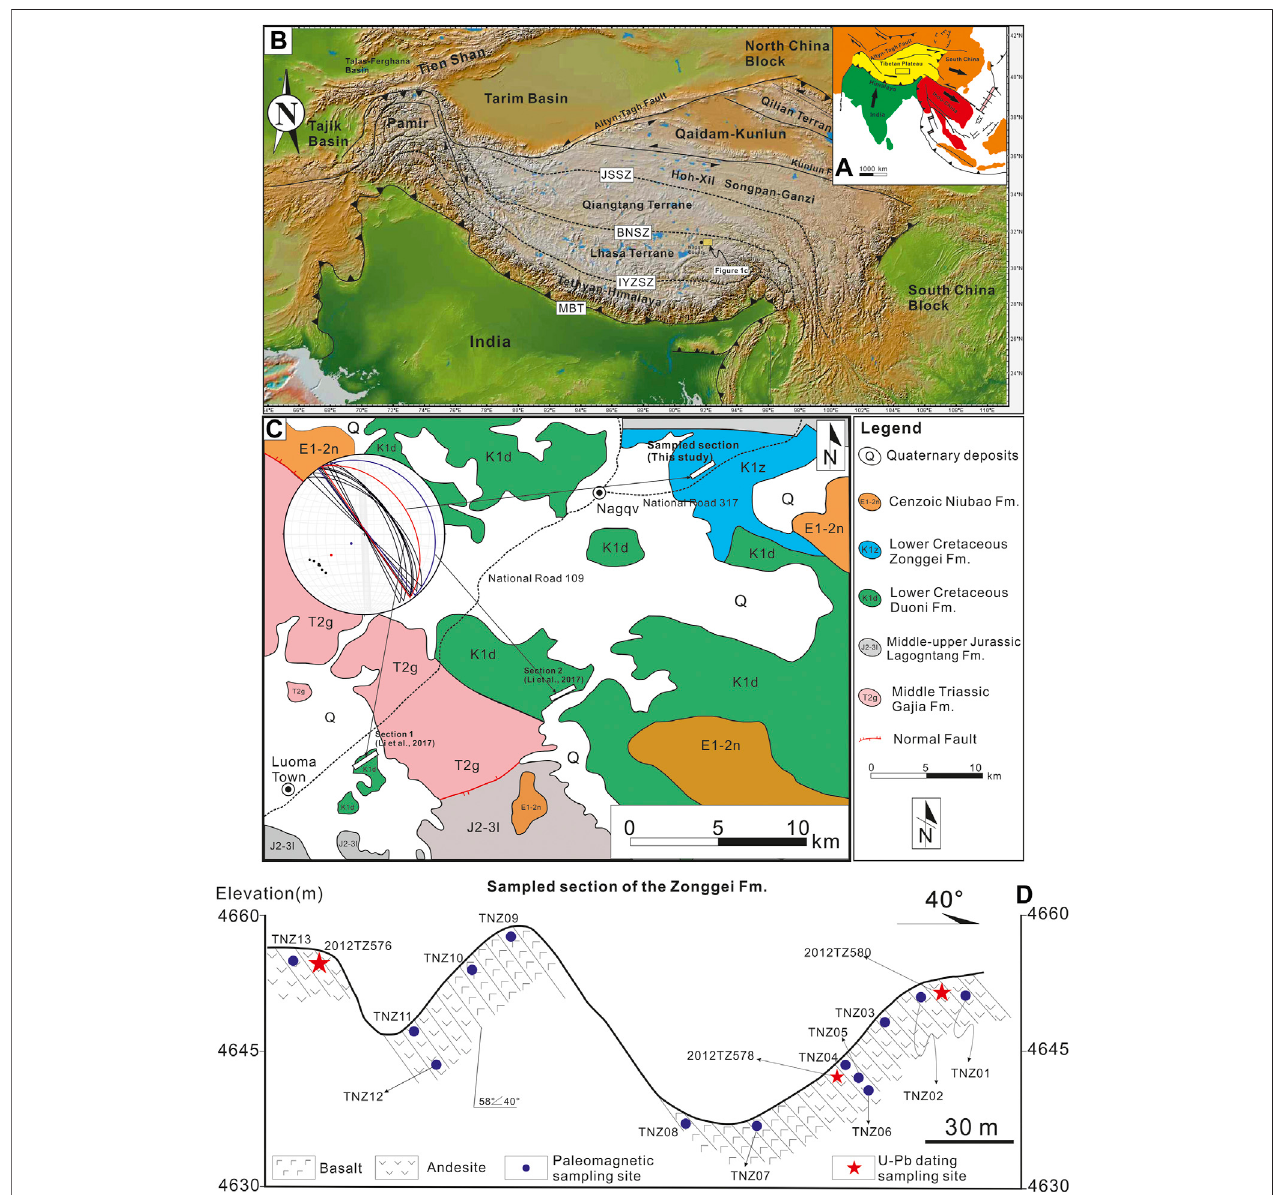
FIGURE 2 | Topographic and geological map of the study area and adjoining areas on the Tibetan Plateau. (A) Tectonic framework of the Tibetan Plateau and neighboringareabasedonTapponnieretal.(1982).Thestudyarea(intheNagquregion)islocatedinthenorthern Lhasaterraneofcentral Tibet(enclosedbyrectangle). (B) Simpli fi ed tectonic division of the Tibetan Plateau and detailed location of the study area in this study. Some abbreviations are as follows: JSSZ, Jinsha suture zone; BNSZ, Bangong-Nujiang suture zone; IYZSZ, Indus-Yarlung Zangbo suture zone; MBT, Main boundary thrust. (C) Geological map of the study area near Nagqu County (scale, 1:250,000), wheretheZonggei Formation volcanicoutcropsarelocatedonthenorthern sideoftheNational Highway317,approximately 5 kmnortheast of Nagqu County. Stereo projection showing bedding attitudes and associated poles to the planes from sampled Section 1 and Section 2 (Li Z. et al., 2017) and the sampled section in this study. (D) Sketched cross section of the Zonggei Formation volcanic rocks wesampled on the northern side ofNational Highway 317; blue dots denote the paleomagnetic sampling sites, while red pentagons denote the sampling sites for U-Pb dating bulk samples.